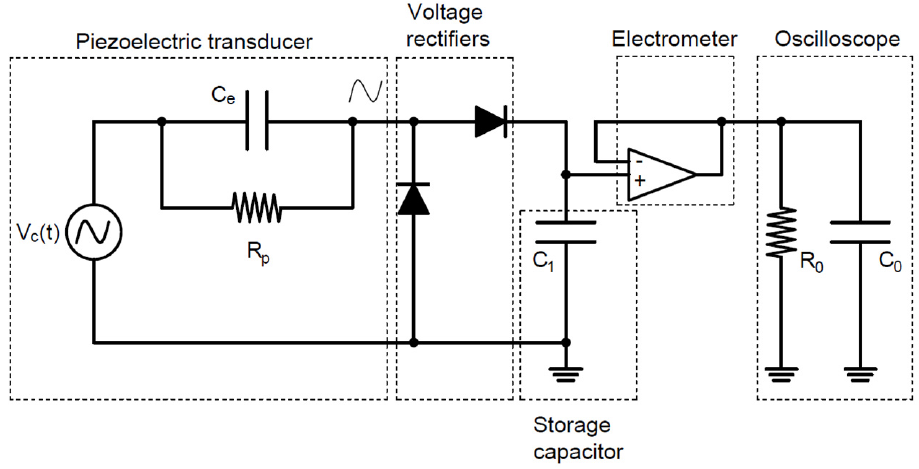
Figure 13. Electrical configuration of the proposed piezoelectric energy harvester.